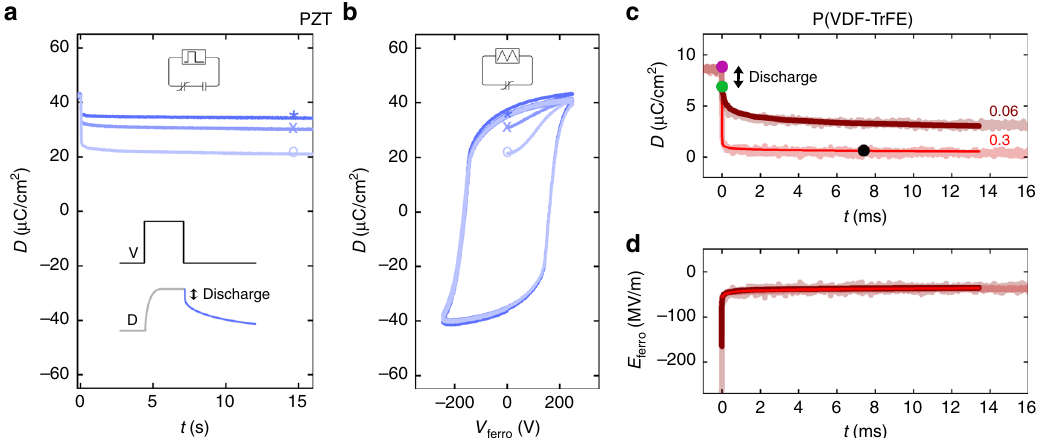
Fig. 3 Depolarization dynamics. a Transients of the electric displacement of a Pb(Zr,Ti)O 3 (PZT) ferroelectric capacitor ( C ferro = 14 nF) with various serial capacitors. The circuit and transient measurement are schematically described in the inset. The transients presented are for C ser as 6 µ F, 330 and 110 nF, corresponding to C ferro / C ser of 0.006, 0.04, and 0.1, respectively. The symbols (*, ×, ο ) mark the value of electric displacement, i.e. the retained polarization, at the end of the transient for each capacitance ratio. b Reading the retained polarization by measuring the ferroelectric-only capacitor after depolarization. The measurement circuit is shown in the inset. The symbols (*, ×, ο ) mark the values of the electric displacement at the end of the transients shown in a , demonstrating that the value of D at the start of the fi rst loop is similar to the retained polarization. c Displacement and d internal fi eld as a function of time for poly(vinylidene fl uoride – tri fl uoroethylene) [P(VDF – TrFE)]. The dynamics of the displacement, after a fast discharge of the induced polarization shown by the double arrow, are given by the solid lines, as obtained by numerical calculation (Supplementary Note 4). The set, discharged and fi nal states are highlighted by the purple, green, and black circles, respectively. C ferro of P(VDF – TrFE) here is 260 pF and the curves correspond to serial capacitances of 4.4 nF and 890 pF, with the respective capacitance ratios indicated